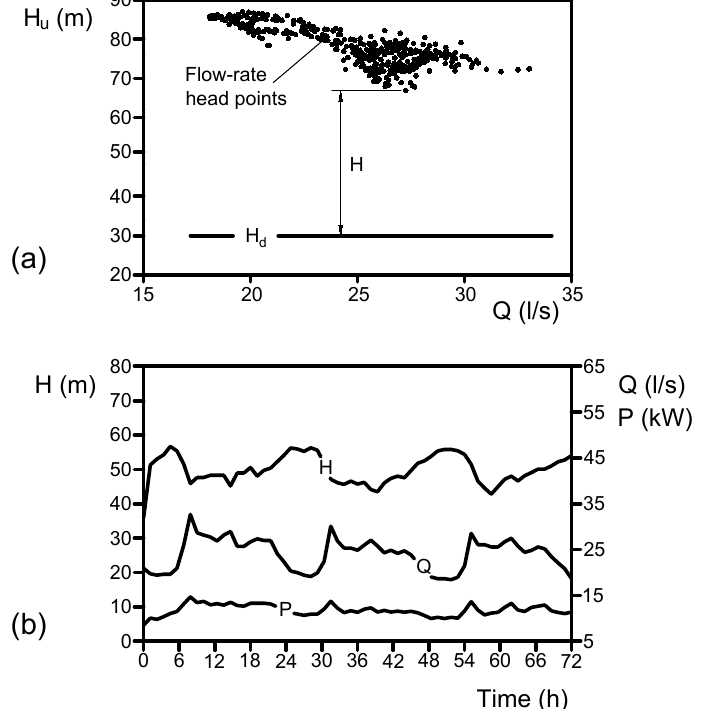
Figure 1. ( a ) Measured pressure head ( H of net-head ( H ), flow rate ( Q ) and available power ( P ) with a given backpressure value = 30 ( H d